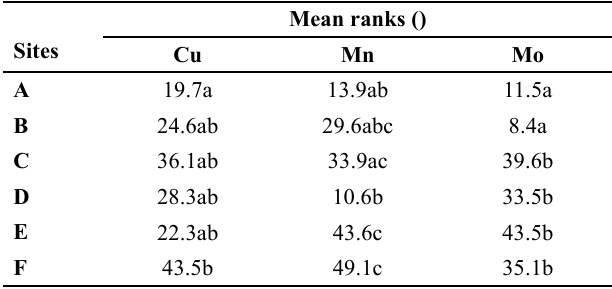
Table 4 . Mean ranks ( different